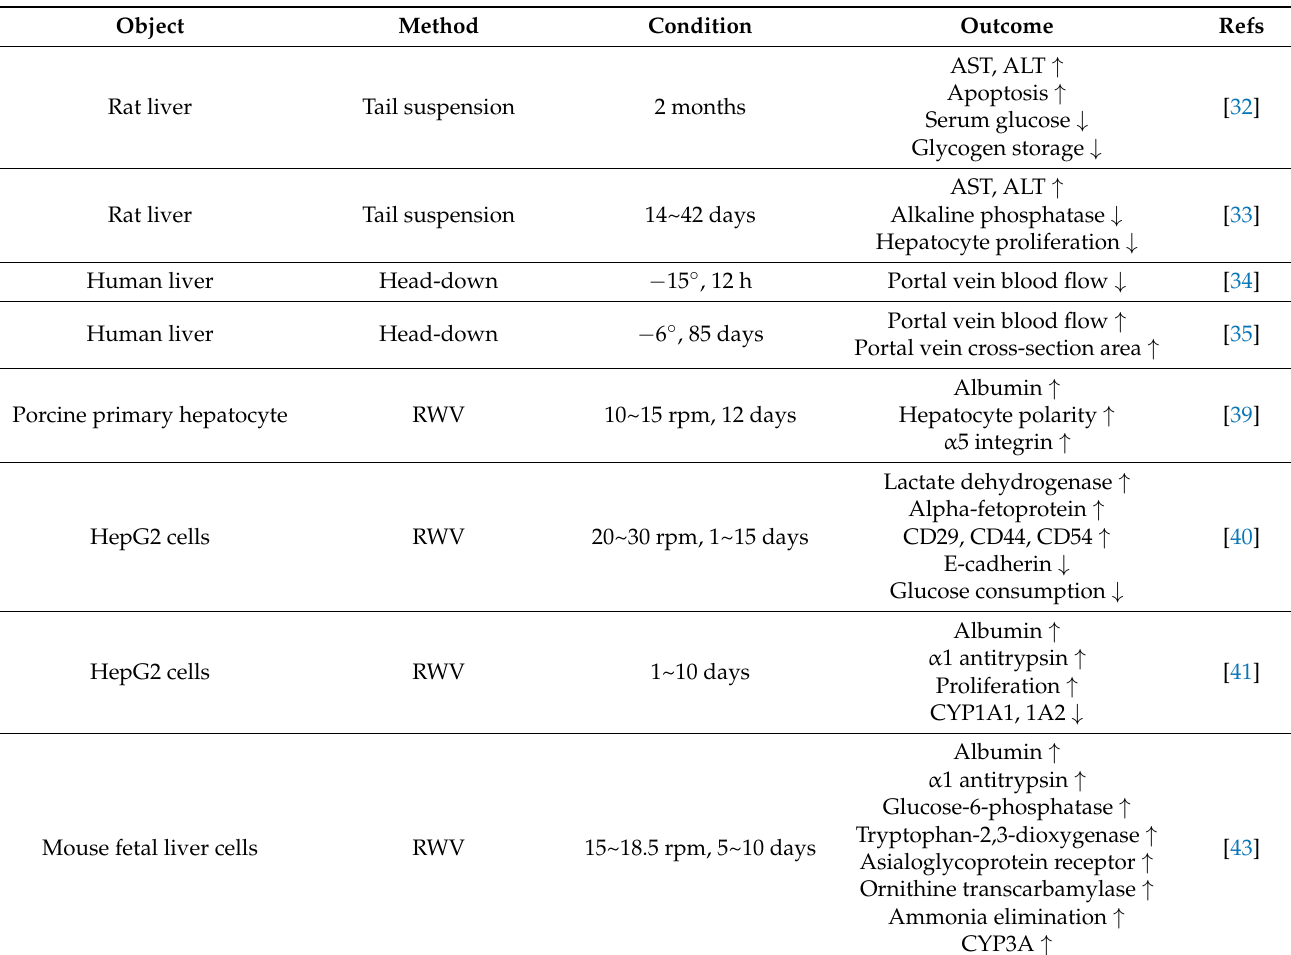
Table 2. Effects of ground-based simulated weightlessness on liver